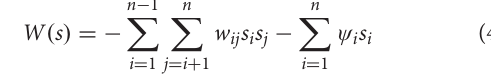
which represents the stability of the network state. The